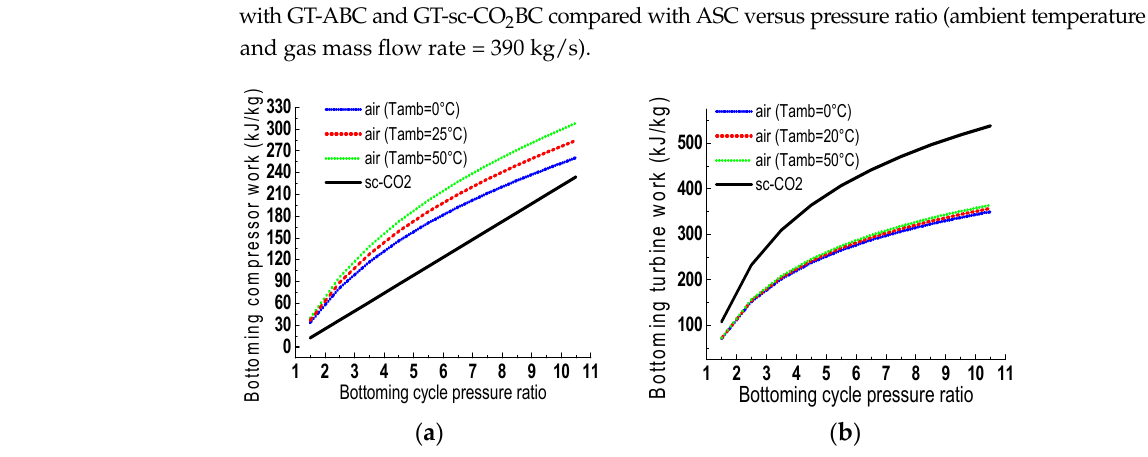
Figure 6. Bottoming compressor work ( a ) and turbine work ( b ) versus bottoming cycle pressure ratio with air at different ambient temperatures and with sc-CO 2 .